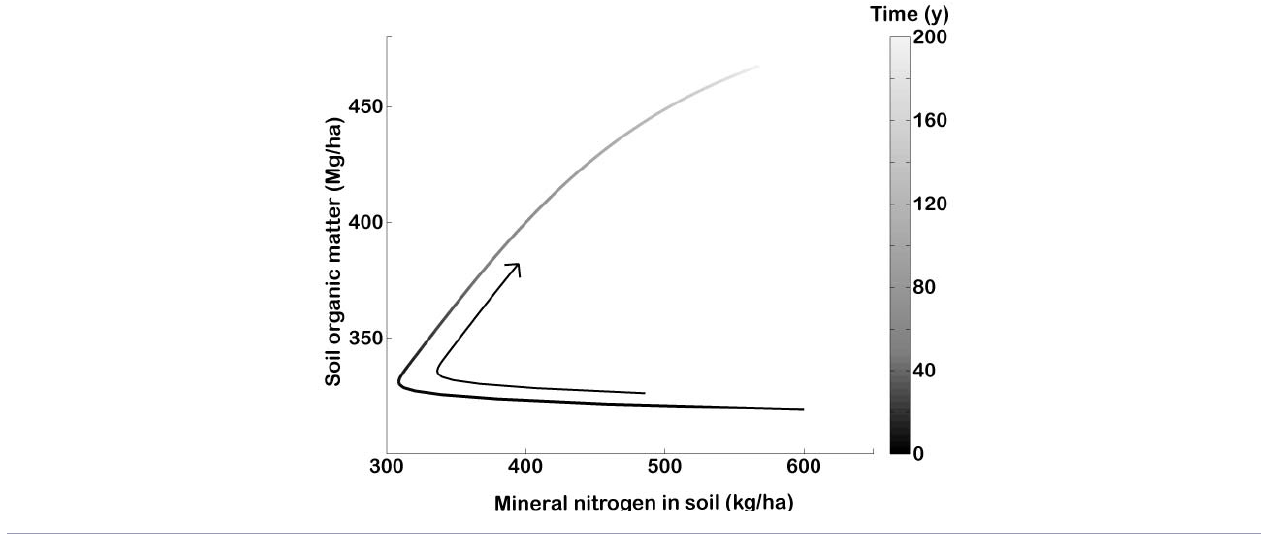
Fig. 5. Modeled trajectory of change (line) in the phase space of mineral nitrogen (N matter. Initial condition is a field after years of maize cultivation, based on Sonneveld et al. (2002), and afterward receiving 125 kg fertilizer N/ha. Mineral nitrogen determines the yield of the field and in 200 years the farmer will have almost the same yield with half of the external fertilizer input. The trajectory is strongly nonlinear, the fast variable of mineral nitrogen decreases steeply, and recovery of this variable is slow with the increase of soil organic